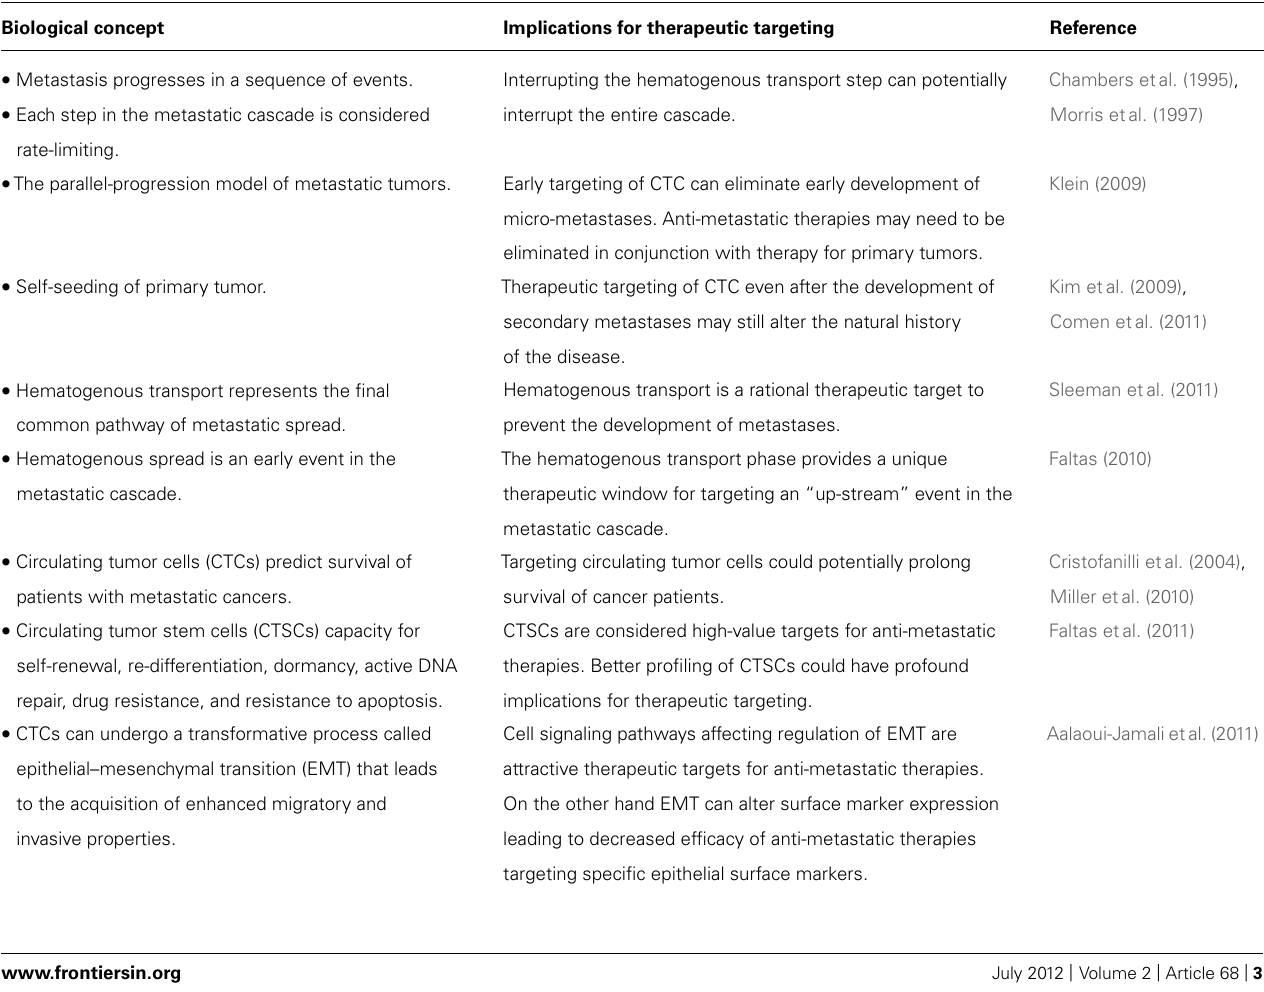
Table 1 | Emerging concepts in metastatic biology and their implications for therapeutic targeting. Biological